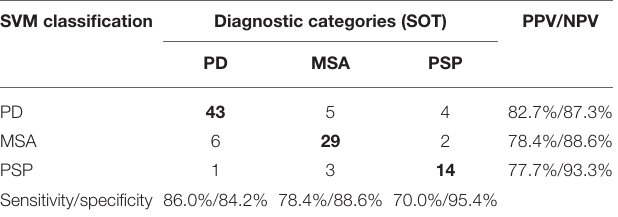
TABLE 4 | Confusion matrix and diagnostic performances of the multi-class classification system of different parkinsonian